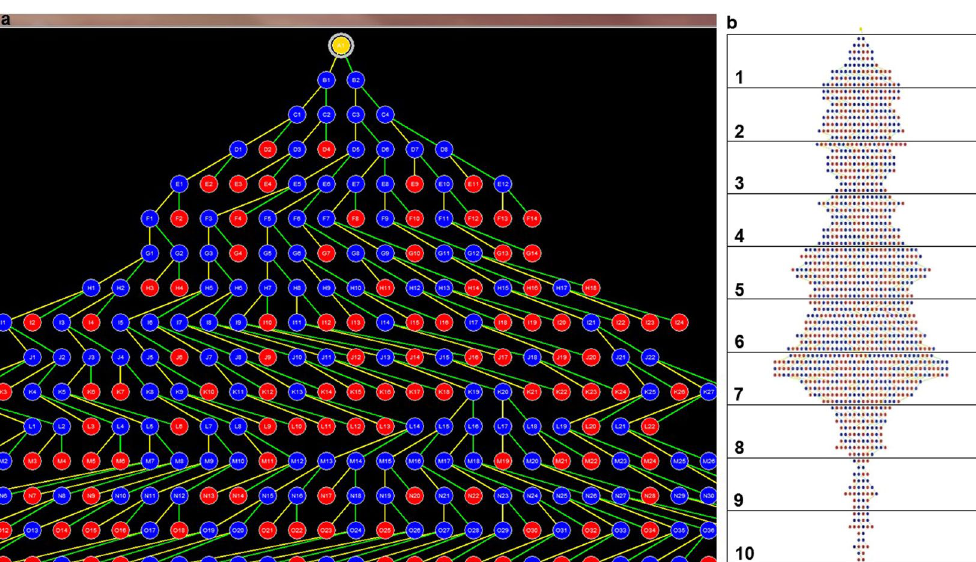
Figure 3. Vessel tree maps generated on Analyze. Panel (a) is a screenshot showing part of a tree map of vessels. The yellow dot at the top represents the root of all the vessels (umbilical cord insertion point). True branch points and terminal branch points are marked in blue and red dots respectively. Each point is labelled with alphabets designating the branch generation/level and numbers designating the branch number at each level. Panel (b) shows a sample tree map grouped into decile (ten groups) of branching. In this example, the total level of branching (excluding the root) was eighty. This was divided into ten groups containing eight levels each. The number of branches in each group was